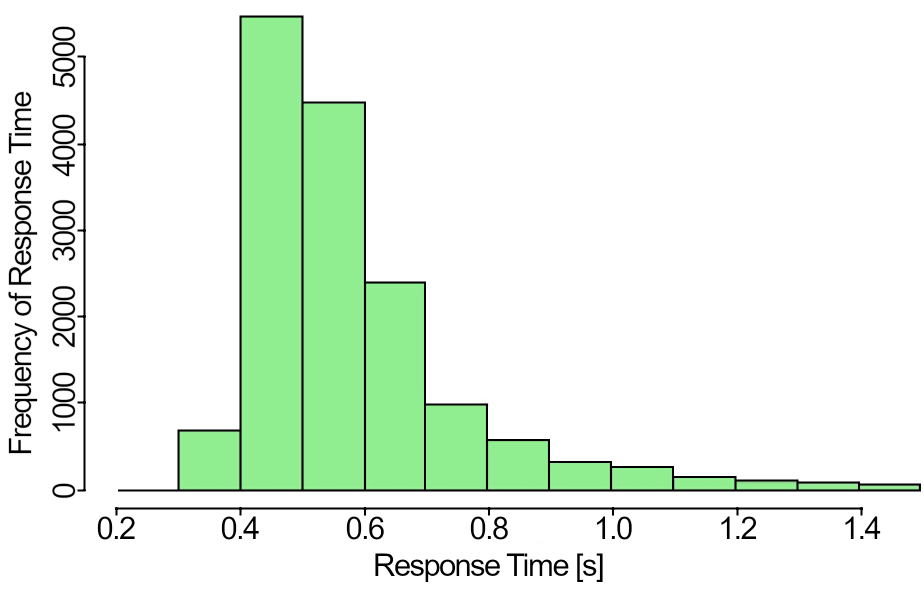
Figure 8. Distribution of response times for all